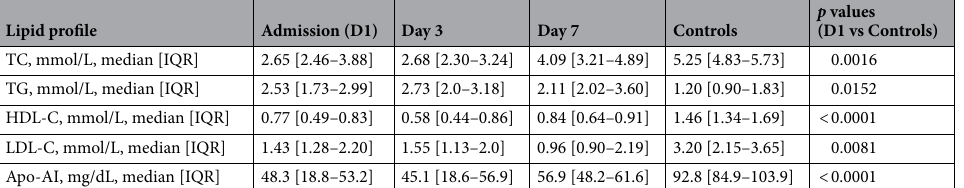
Table 2. Lipid profile and plasma ApoA-I concentration in COVID patients and control subjects. Mann– Whitney test was performed to compare the lipid profiles of controls (n = 16) versus COVID-19 at admission (n = 8) patients. TC, total cholesterol; TG, triglyceride; HDL-C, High-density lipoprotein cholesterol; LDL-C, Low-density lipoprotein